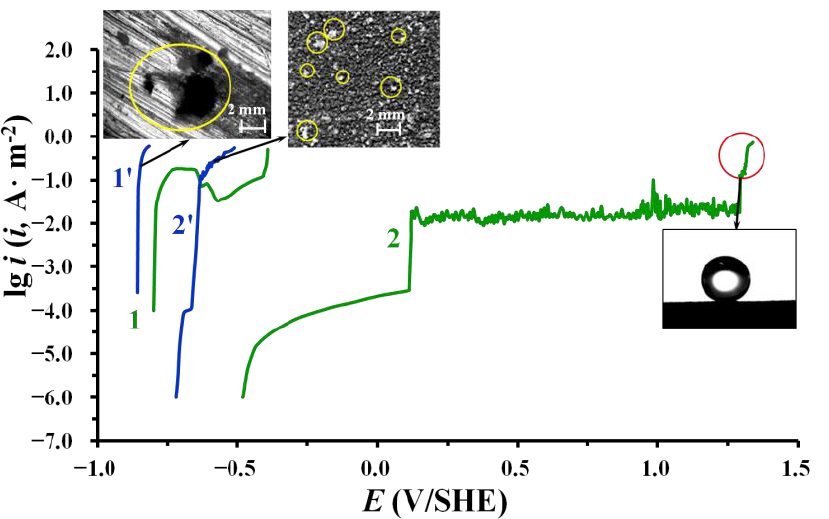
Figure 4. Anodic polarization curves of zinc in borate buffer solution (pH 7.4) containing (1,2) 0.001 and (1′,2′) 0.5 M of NaCl, (1,1′) without any treatment and (2,2′) after laser and layer-by-layer treatment in solutions of 2.5 mM SDDP and 10.0 mM OTES.